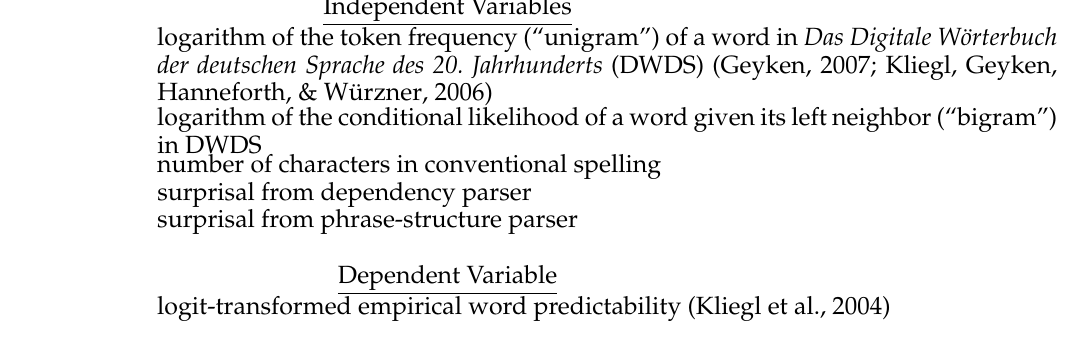
Candidate explanatory factors for empirical predictability.